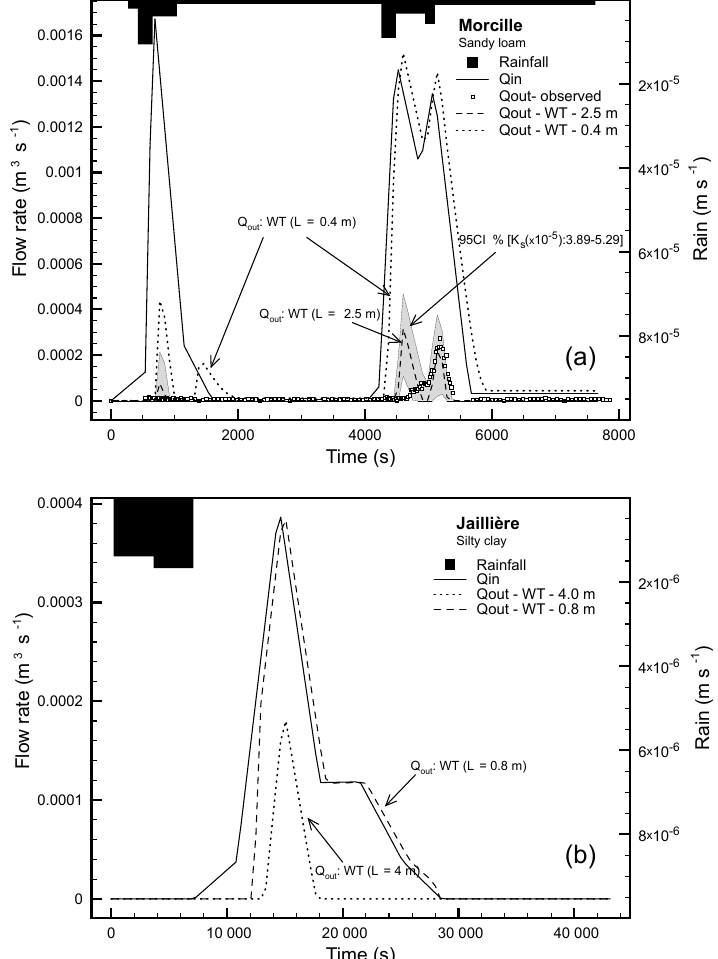
Figure 4. Hydrological response of the VFS at the study sites. (a) Event at Morcille 17 August 2004 with L = 2 . 5m, showing comparison of measured outflow (symbols) and VFSMOD simulations (lines). The dashed Q out line for L = 2 . 5m corresponds to average conditions for that event ( K s = 4 . 58 × 10 − 5 ms − 1 ), and the gray envelope represents outflow variability due to uncertainty of measured hydraulic conductivity. (b) Event at Jaillière on 16 February 1997 with L = 0 . 8m, without outflow measurements. Q in and Q out represent surface inflow and outflow at the VFS. The potential effect on overland outflow of alternative water table depths in those events is represented by the dotted lines for L = 0 . 4 (a) and 4.0m (b)